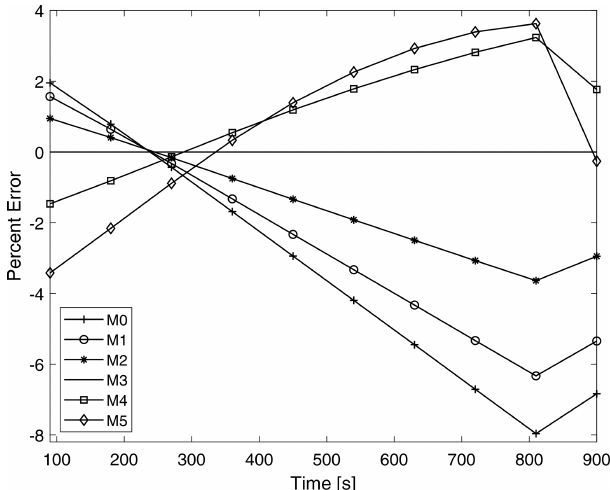
Figure 11. Time evolution of the errors corresponding to the pre- dicted moments from P-DNN. The percent error is taken relative to the moments of KCE. The moments of KCE were calculated by integrating the reference drop number concentration spectra using Eq. (3), while the total moments from the P-DNN were calculated using the predicted distribution parameters to solve Eq.